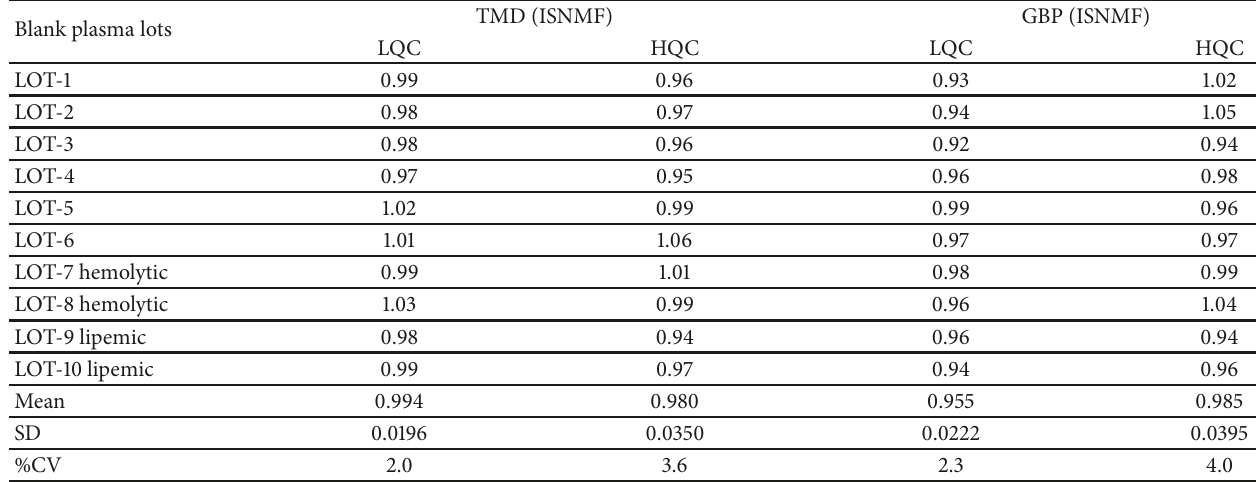
Table 4: Matrix effect results of TMD and GBP.